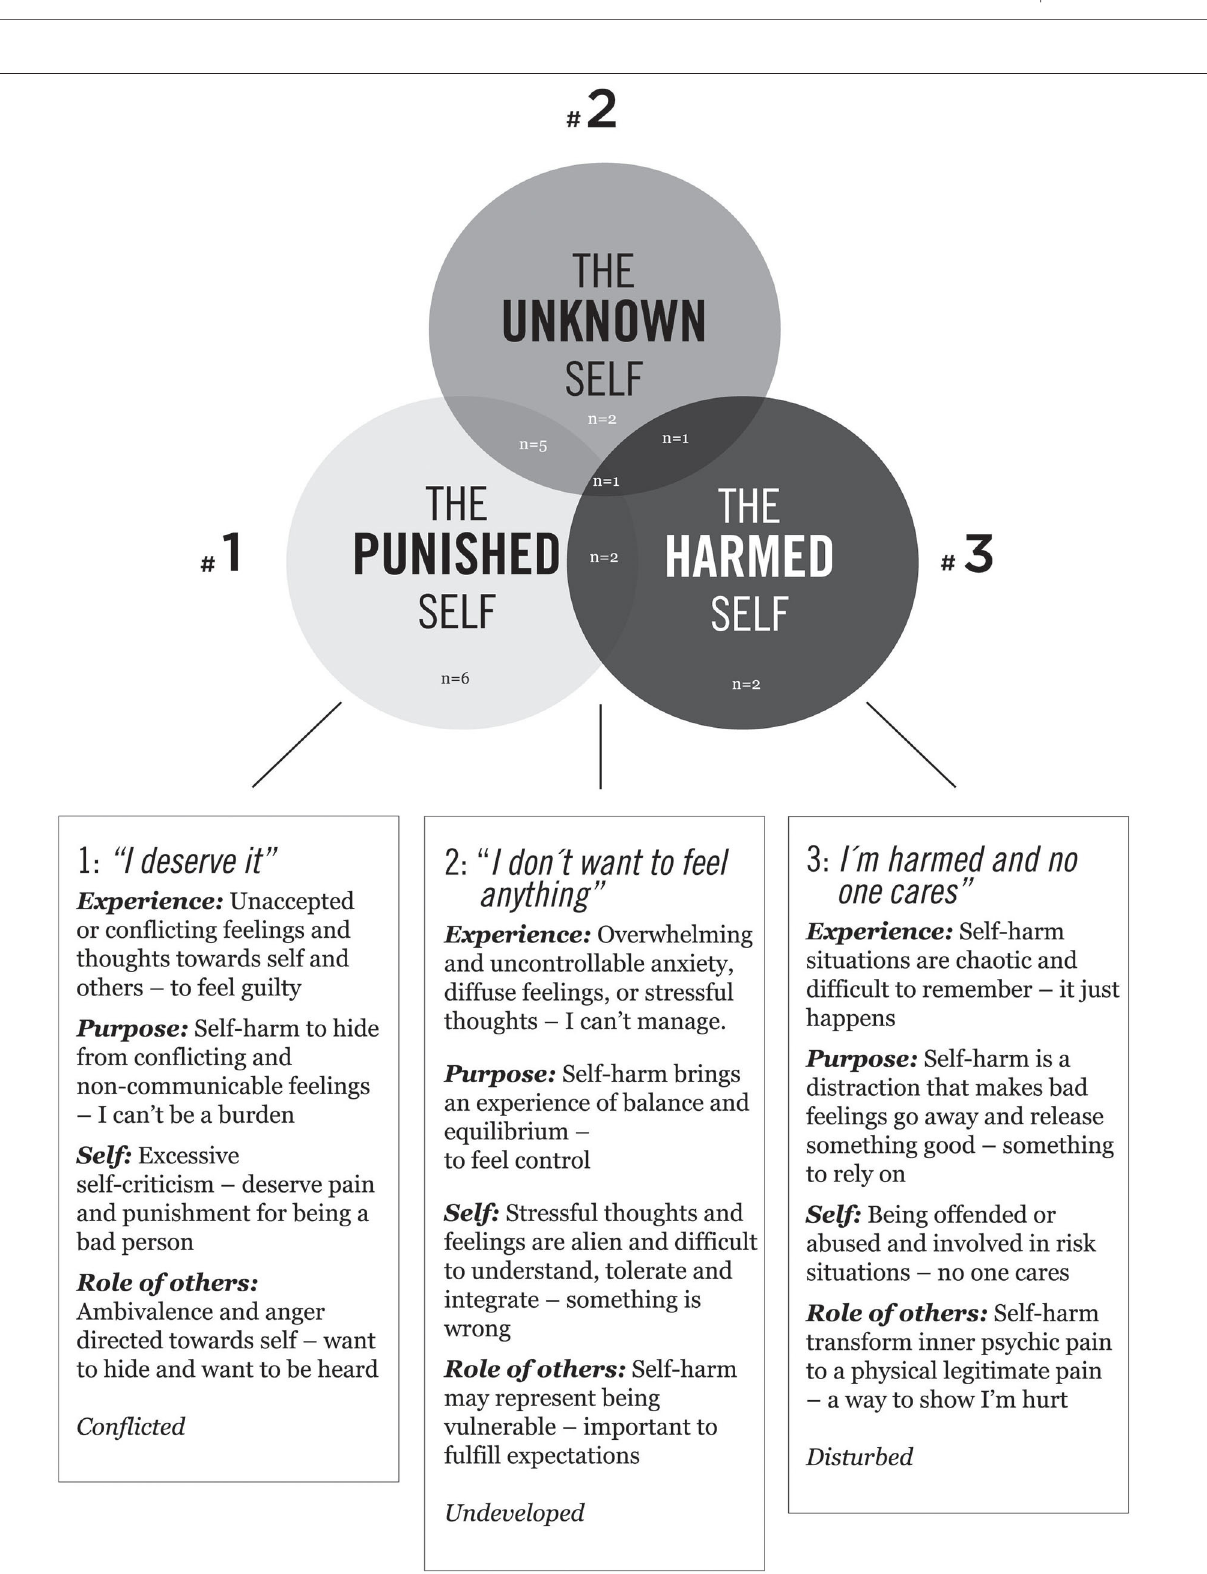
Frontiers in Psychology |